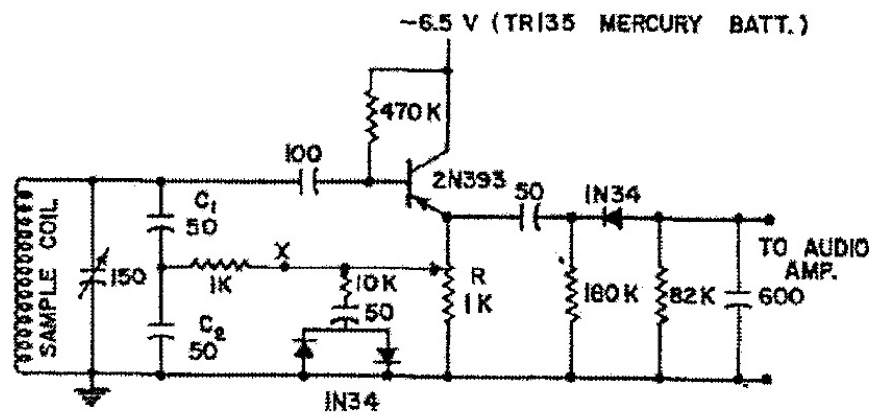
Figure 8. The Donnally Saunders marginal oscillator. (reproduced with permission from [22]. Copyright AIP, 1960).